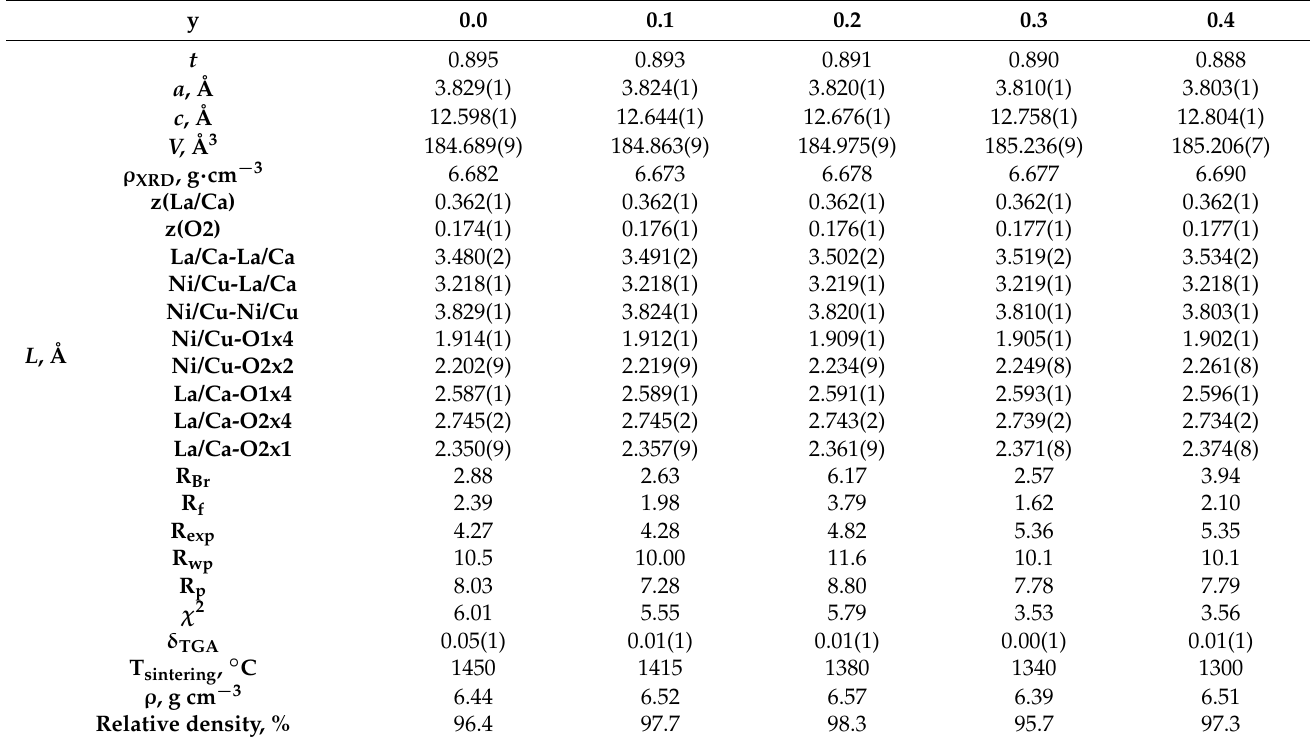
Table 3. Tolerance factors, refined structural parameters, and absolute oxygen